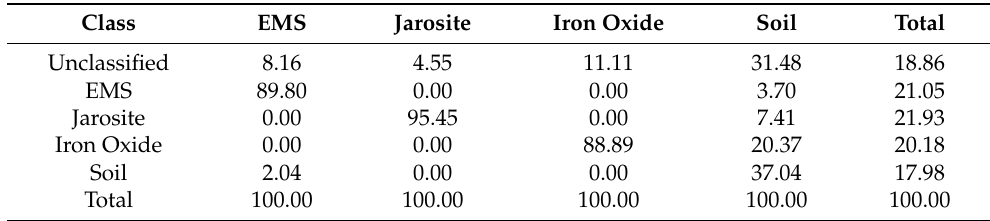
Table A5. November 2018 maximum likelihood. Overall accuracy points: Overall 150/228, overall accuracy: 65%, kappa coefficient: 0.5742.